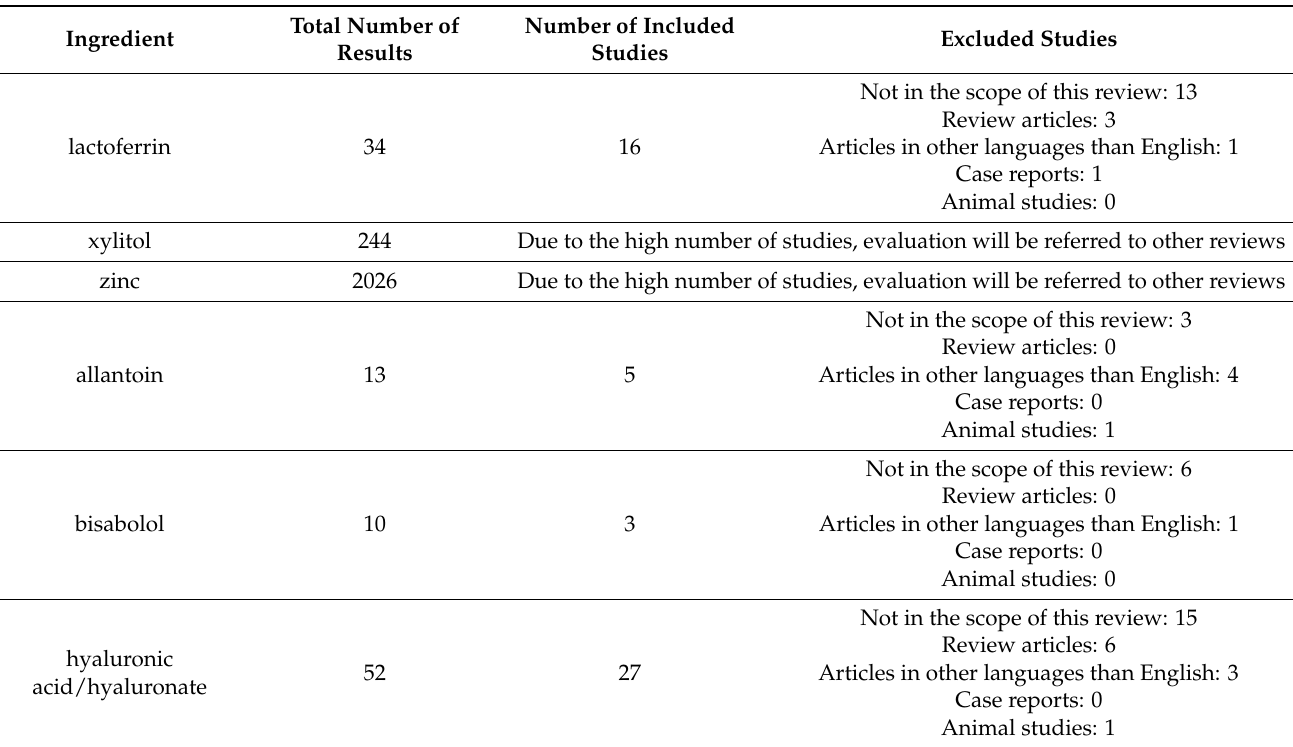
Table 1. Total results of the PubMed search of selected ingredients that are used as adjunct ingredients in hydroxyapatite oral care products (for details on the search see Section